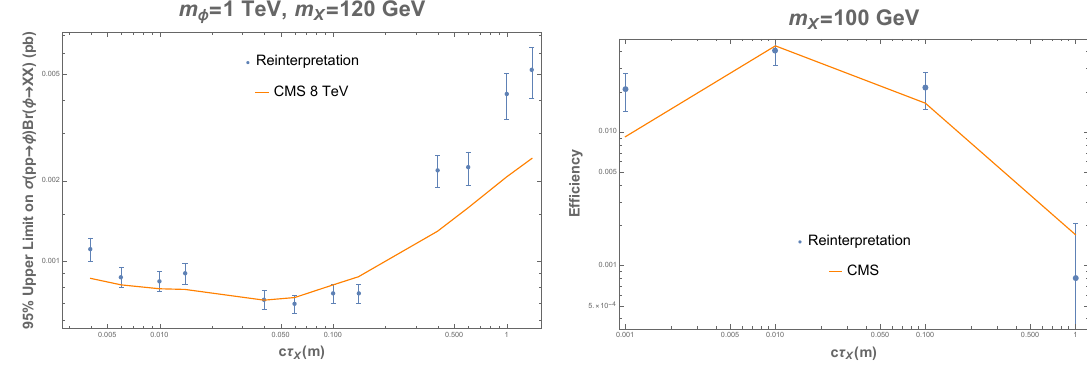
Figure 9 . In both panels the orange line is the result given by the experimental collaboration and the blue dots correspond to the result of our reinterpretation, where the error band are estimated from our montecarlo by taking the variable we are plotting and multiplying it by 2 = N are the number of events passing the cuts. Left: a comparison between the 95% cross section times branching ratio limits placed by the CMS IT analysis at 8 TeV [35] and our reinterpretation as described in appendix B.2 for an example mass point, m (cid:30) = 1000 GeV, m X = 150 GeV. Right: a comparison between the e(cid:14)ciency reported by the CMS IT analysis at 13 TeV [33] and our reinterpretation as described in appendix B.3 for an example mass point m X = 100 GeV. Since no heavy resonance interpretation was directly given by the collaboration we validate our analysis on the jet-jet model of [33] (see text for further